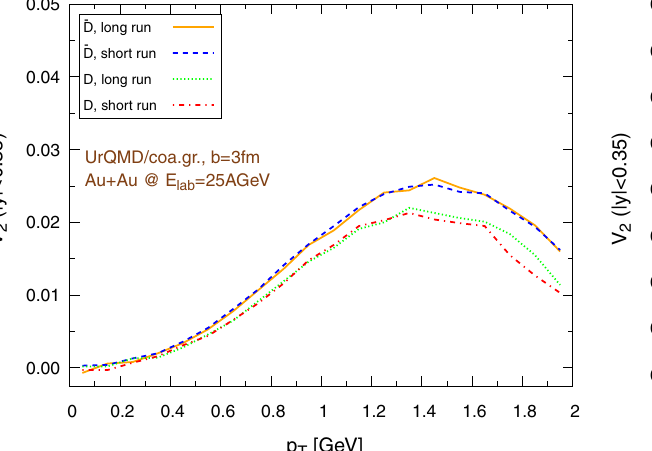
tic flow of D mesons ( | y | < 0 . 35) within the coarse-graining approach (cid:14) (cid:13) = r D at two different final times: 75fm ( long run ) and 22fm ( short run , rms b = 3fm ) or 19fm ( short run , b = 7fm)